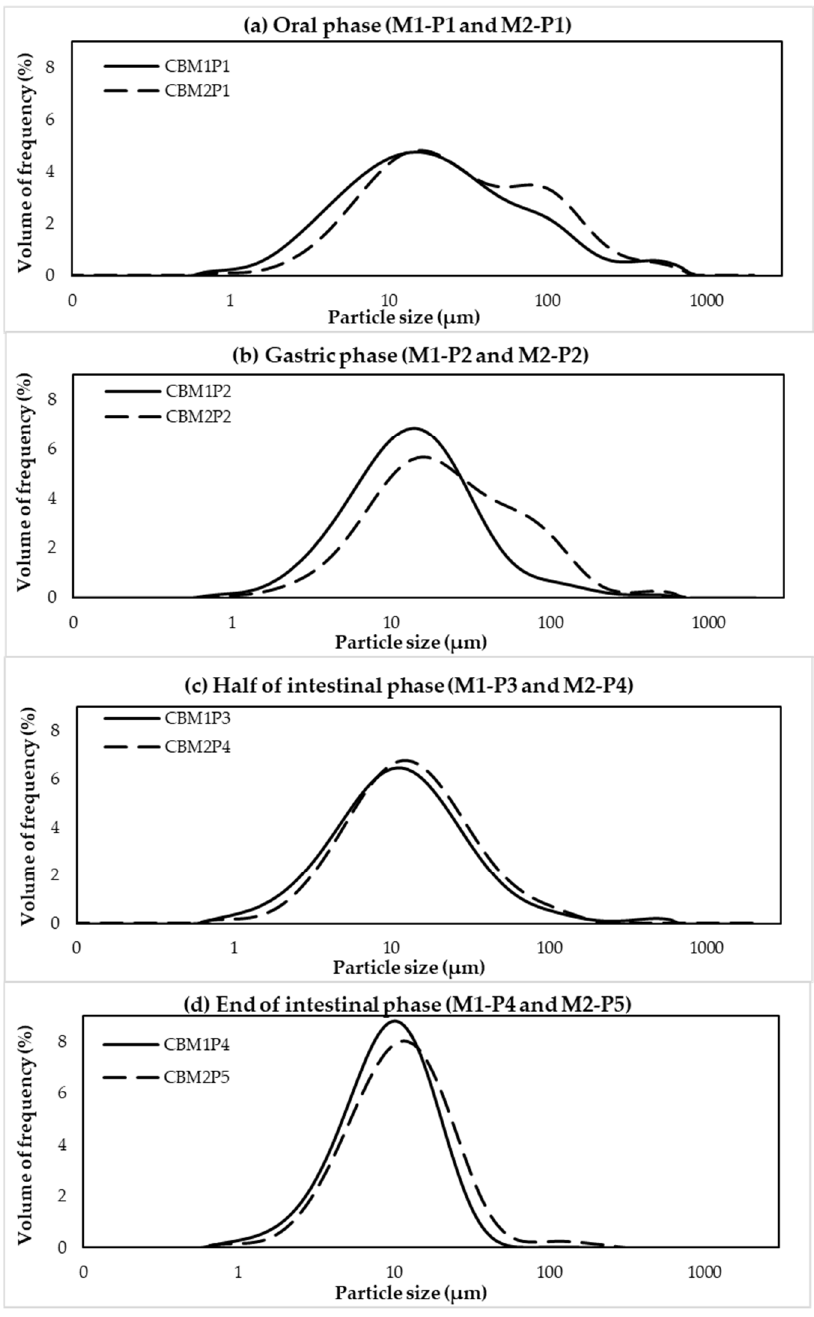
Figure 4. Particle size distribution of commercial broiler breasts (CB) digested by method 1 (M1) and method 2 (M2) and collected at end of oral phase ( a ); end of gastric phase ( b ); and half ( c ); and end ( d ) of intestinal phase. Table 2. Volume weighted mean (D[4,3]) of commercial broiler breasts (CB) digested by method 1 (M1) and method 2 (M2) 2 and collected at different digestion point.